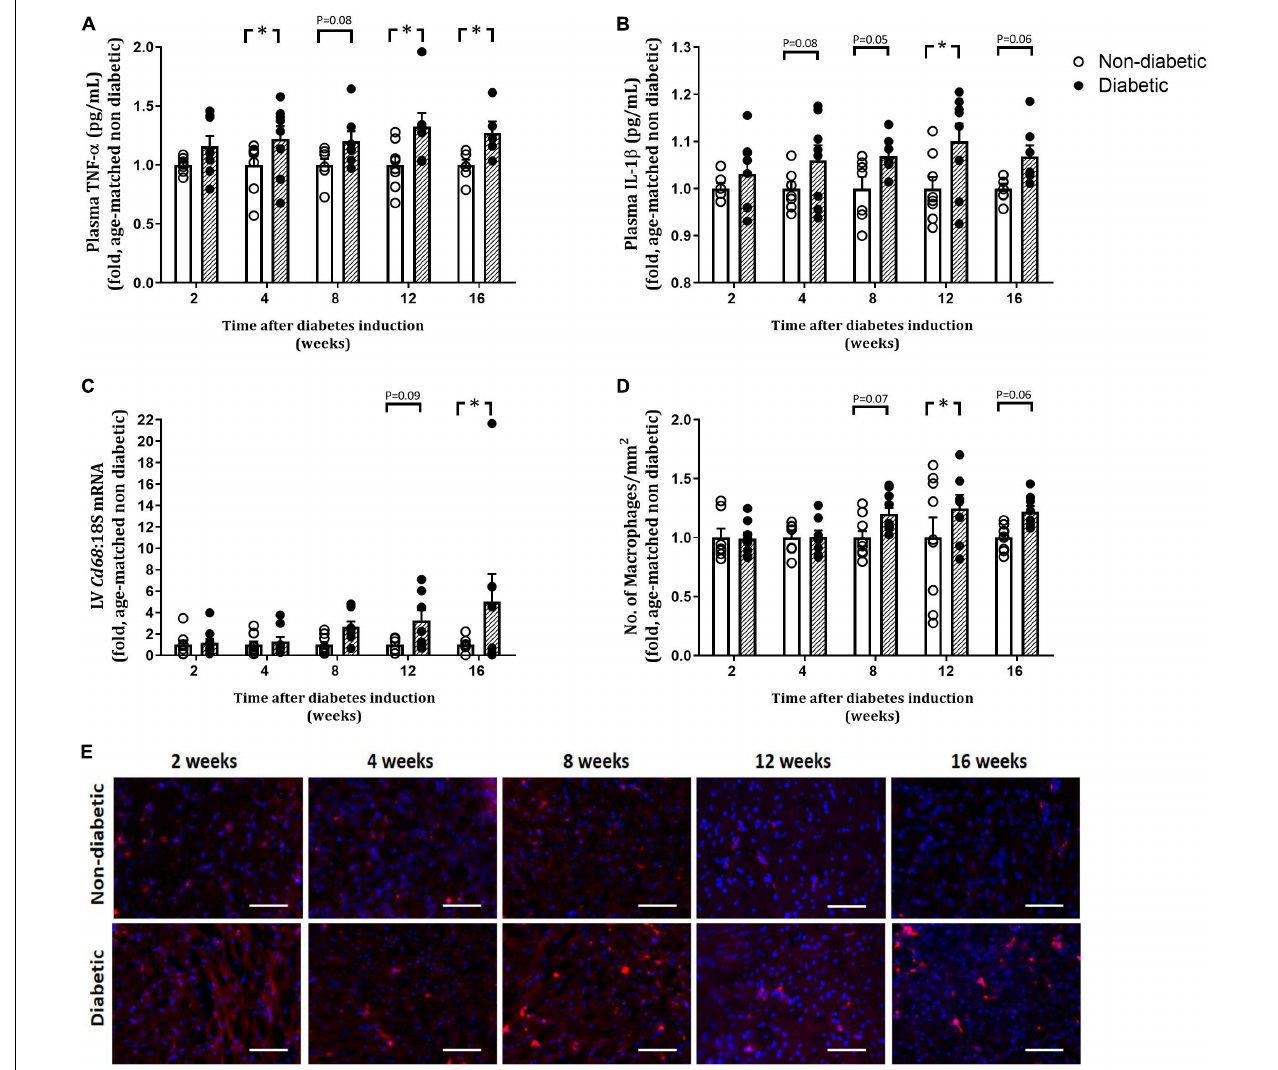
FIGURE 4 | Measures of inflammation. Plasma TNF α and IL-1 β were measured by ELISA (A,B) . LV gene expression of Cd68 is shown (C) . CD68 positive cell count and representative images for CD68 macrophage stained red/pink displayed at each endpoint is shown (D,E) . Scale bar = 100 µ m. Data are presented as mean ± SEM. * P < 0.05 vs age-matched non-diabetic mice (two-way ANOVA with Benjamini and Hochberg post hoc test). n = 5–10/group (refer to Supplementary Figure S1